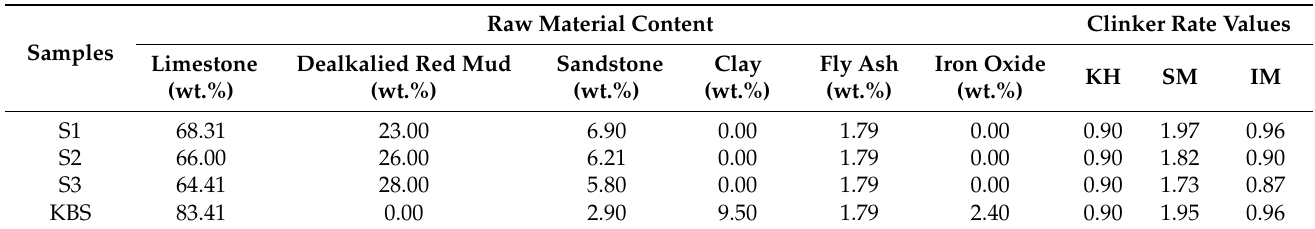
Table 2. Composition of the designed clinker of Portland cement for roads.